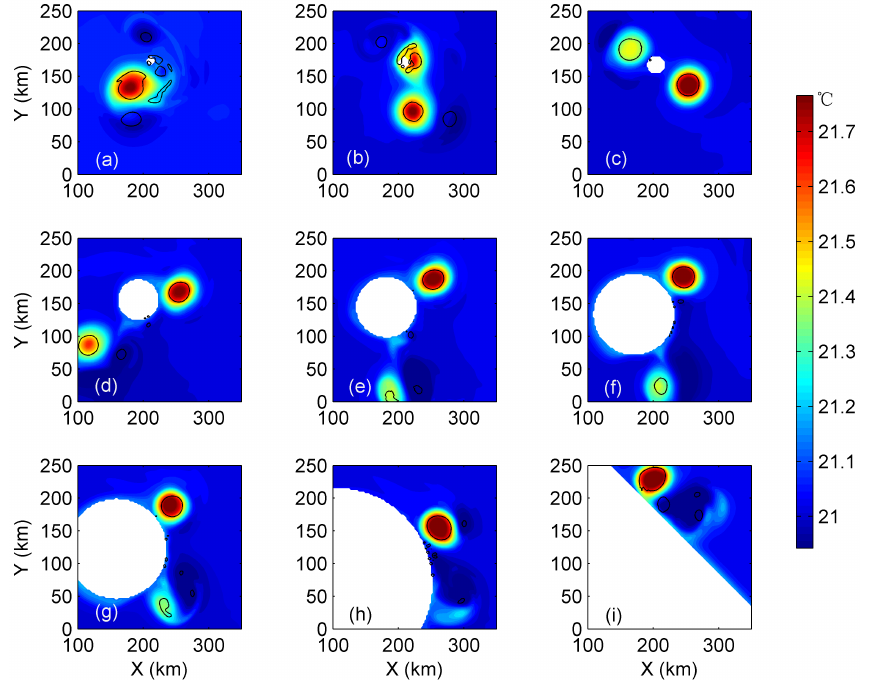
Figure 11. The results of the eddy–island interaction after 50 days for islands with different diameters (a) 10km, (b) 15km, (c) 25km, (d) 60km, (e) 90km, (f) 120km, (g) 150km, (h) 300km and (i) infinite. The colours represent temperature at 100m depth and the black solid lines are the O – W parameter with a value of − 0.2 σ w .